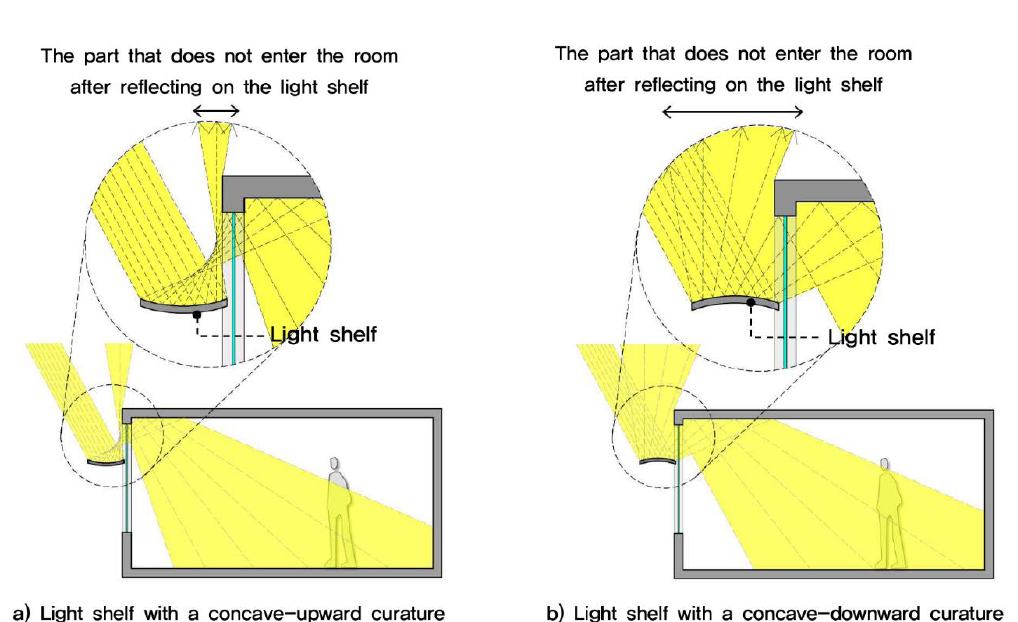
Figure 6. The inflow of light according to the curvature of the light shelf.